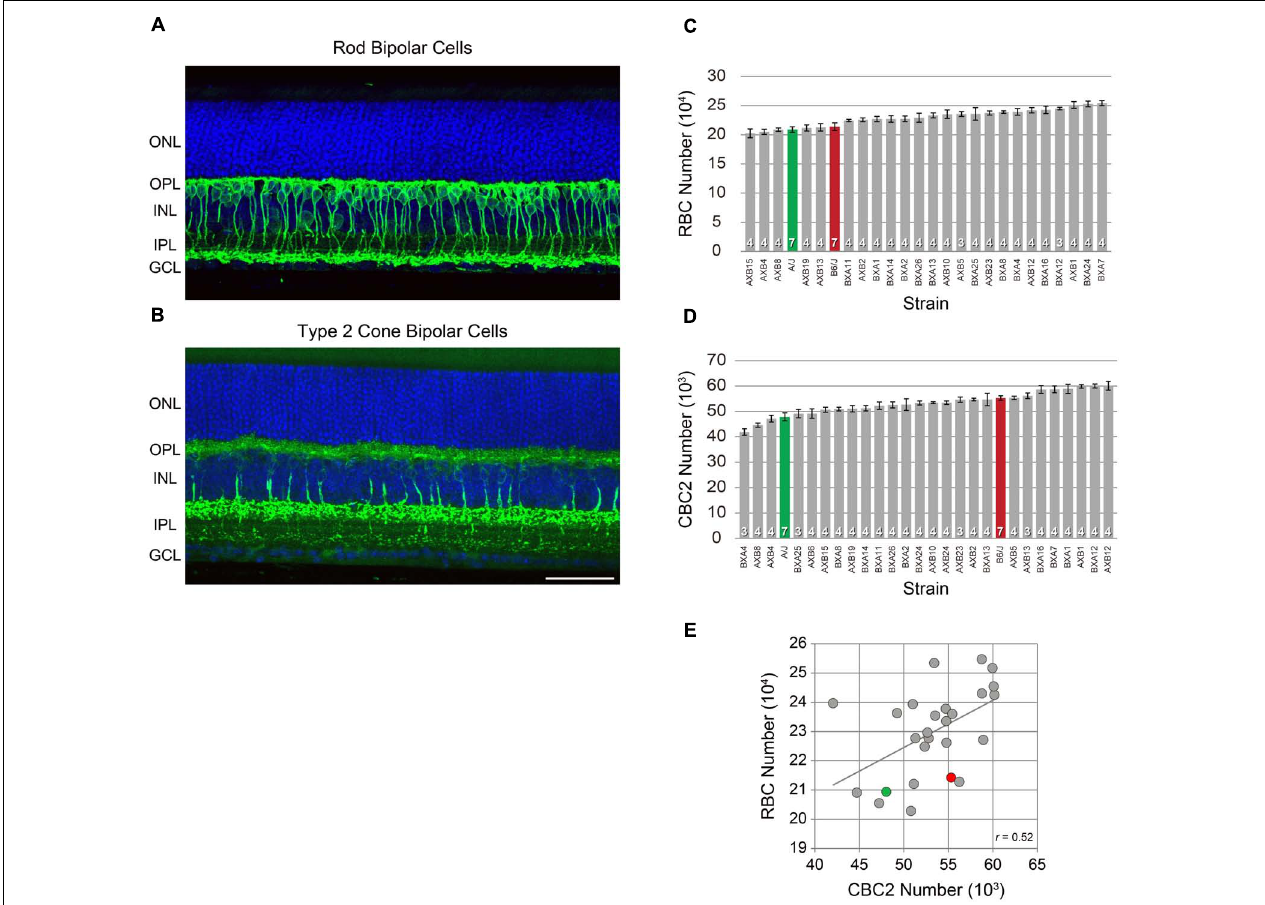
FIGURE 1 | RBCs were labeled using antibodies to PKC (A) , while CBC2s were labeled using antibodies to SYT2 (B) . Each antibody labeled the somata, dendritic arbors, axons, and terminals. Both are shown here in retinal sections taken from adult B6/J mouse retinas, but were quantified in retinal wholemounts by counting their labeled axons. RBC number (C) and CBC2 number (D) each showed conspicuous variation across the RI strains of the AXB/BXA strain set (gray) in excess of the difference between the two parental strains B6/J (red) and A/J (green). n = the number of eyes sampled from different mice in each strain. (E) Cell number co-varied across the strains. Pearson’s correlation coefficient was statistically significant ( p < 0.05). Scale bar = 50 µ m.